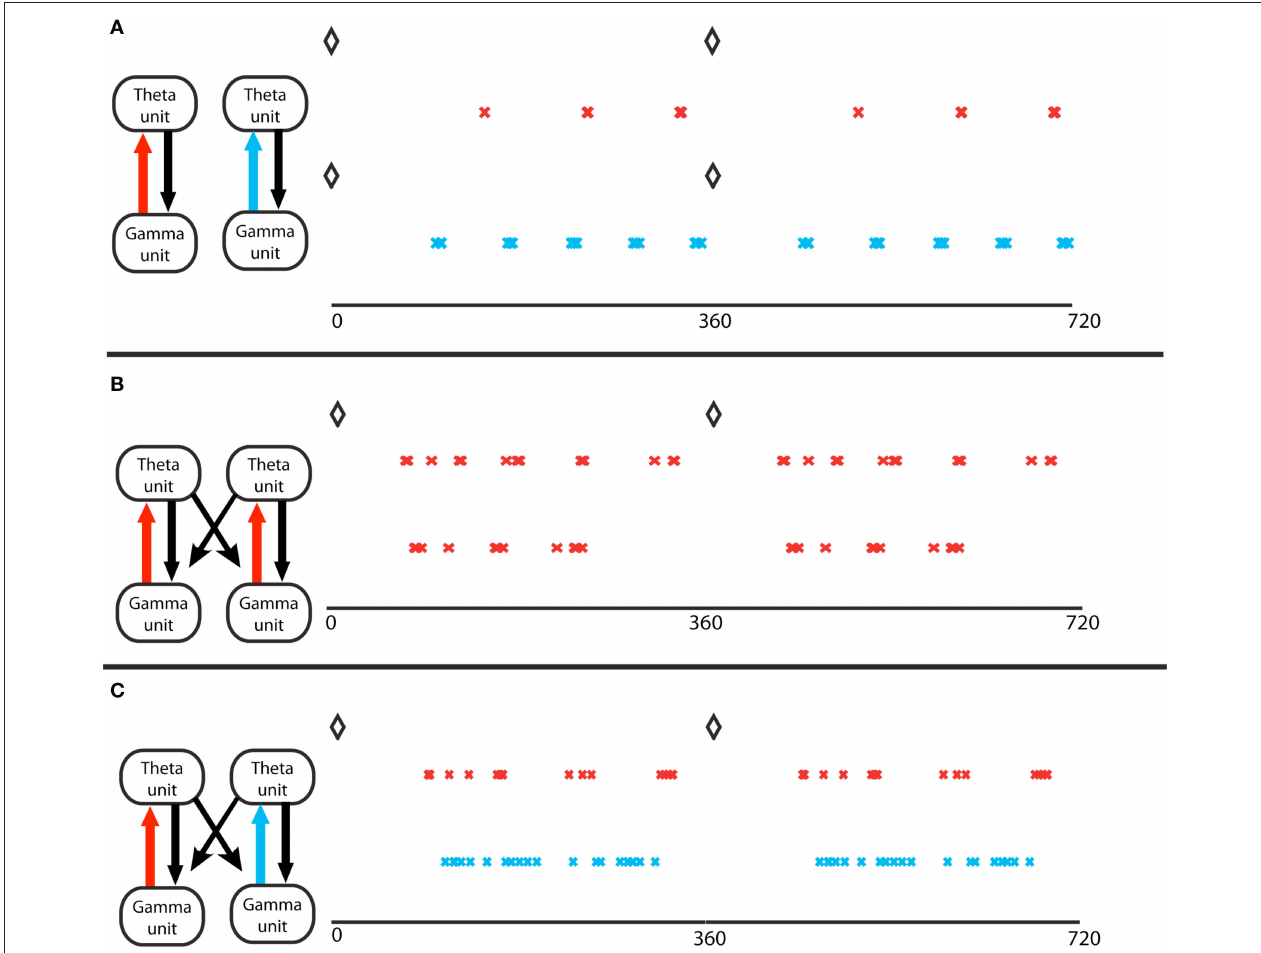
gamma drives. The spike phases on top are for the pyramidal cell of the module that receives stronger gamma drive. The two cell assemblies do not synchronize (Tort et al., 2007). (C) Two coupled modules, receiving identical gamma drive, in different excitation regimes. The red crosses mark activity of the module in ED regime, the light blue marks report activity of the module in ID regime. The theta phases of the gamma spikes in the ID regime do not cluster, so the two gamma signals in the two different modules have the same frequency but have different theta